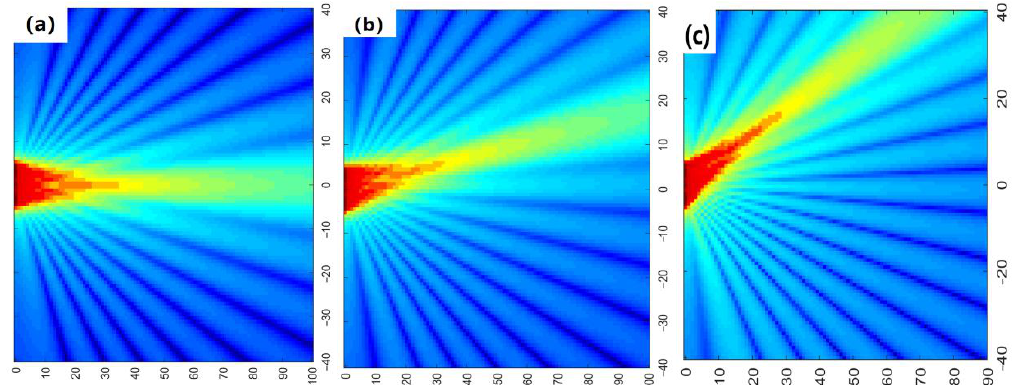
Figure 18. Sound pressure diagram of xoz plane: ( a ) without rotation; ( b ) 10° rotation; ( c ) 30° rotation.